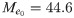
Boxplot of parameters for model (3) after fixing the value Me0=44.6.Same as in Fig 5, we remove the outliers and normalized the filtered estimations for model (3). The black dots correspond to the best estimation for the model (best fit to real data, MSE = 642.63). Since the initial condition Me0 has been fixed, it has also disappeared from the boxplot. Note that θh and Hr0 are even less identifiable for this model relative to the other models.